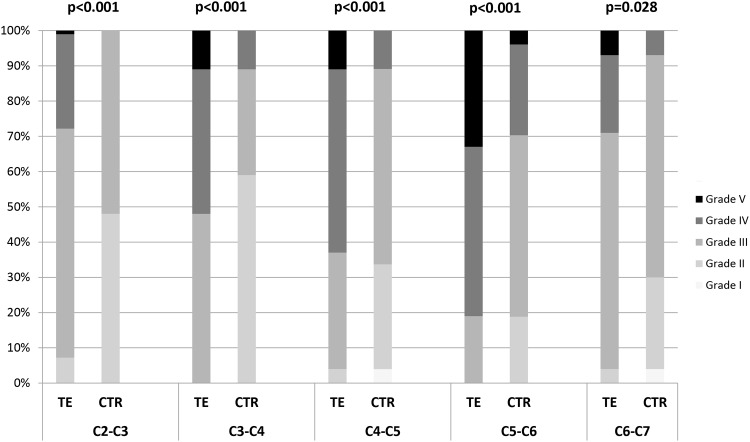
Disc degeneration evaluated by Pfirrmann classification on MRI.Pfirrmann grading (I-V) of all cervical discs in 27 individuals with thalidomide embryopathy (TE), and 27 aged- and gender matched control subjects (CTR). Each cervical level (C2-C3-C6-C7) is presented separately and Fisher Exact Test was used for comparison between the two groups. Significant differences between the two groups were seen at all levels (p-values in the figure).